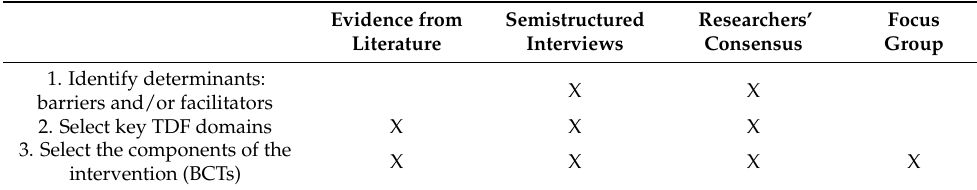
Table 1. Origin of data by stage of